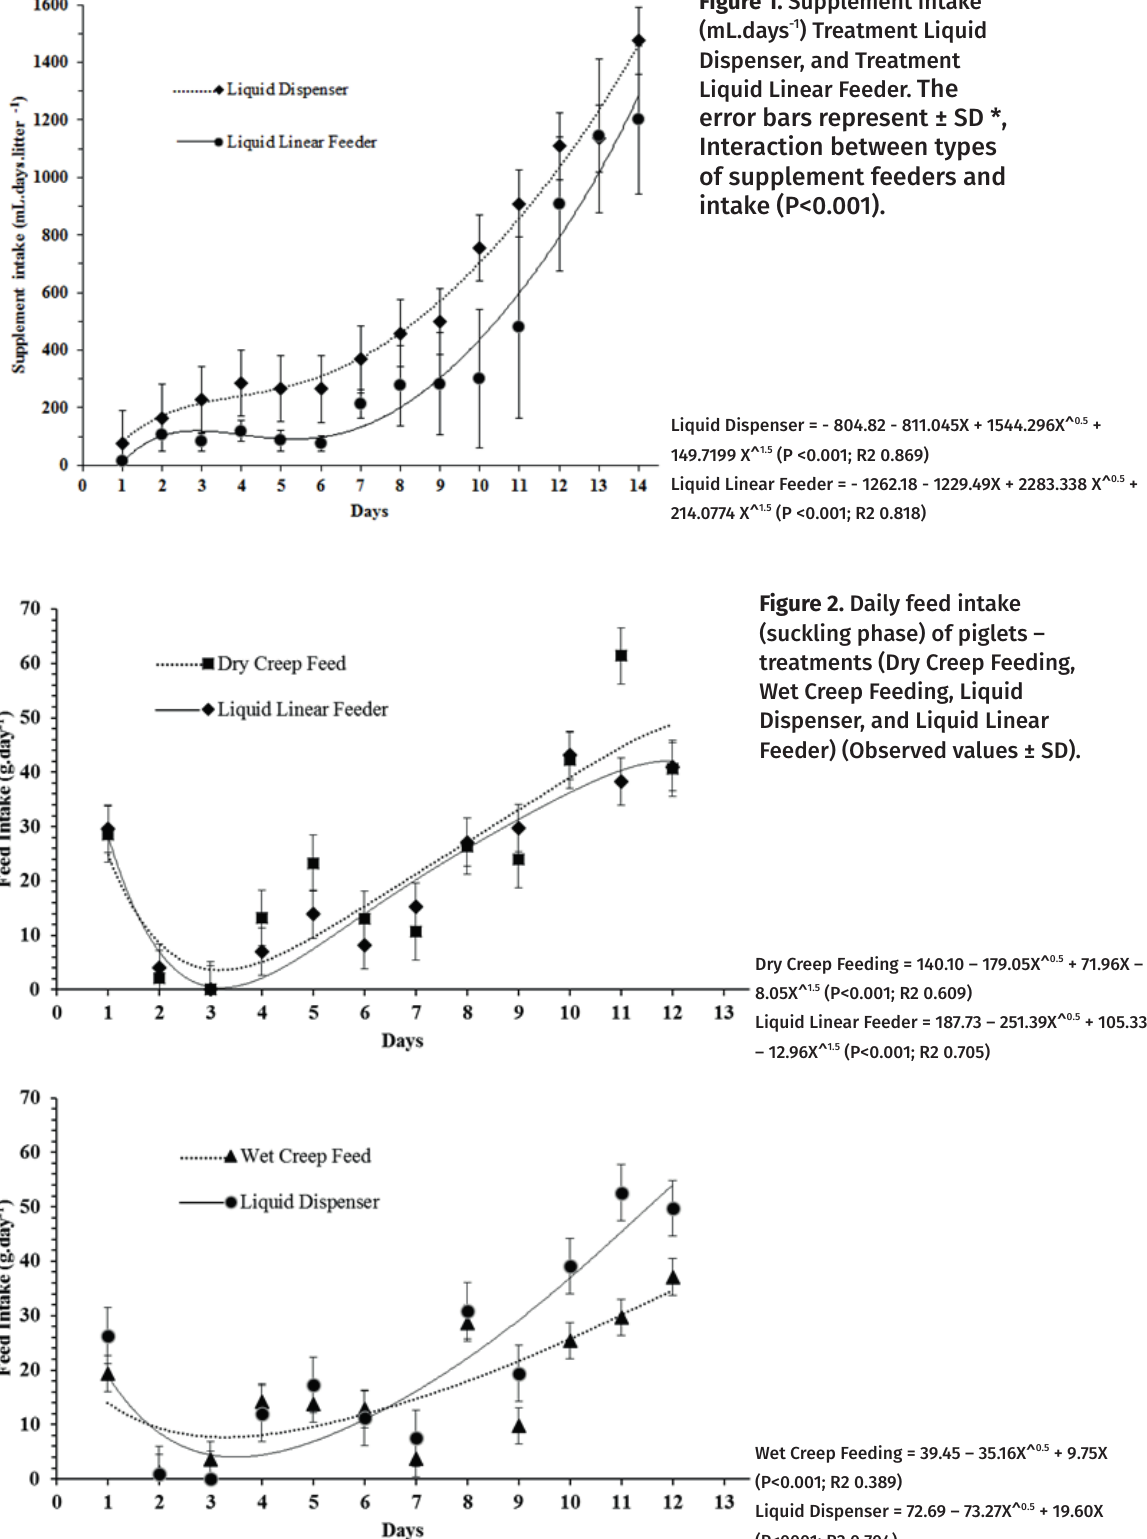
Figure 1. Supplement intake (mL.days -1 ) Treatment Liquid Dispenser, and Treatment Liquid Linear Feeder. The error bars represent ± SD *, Interaction between types of supplement feeders and intake (P<0.001).